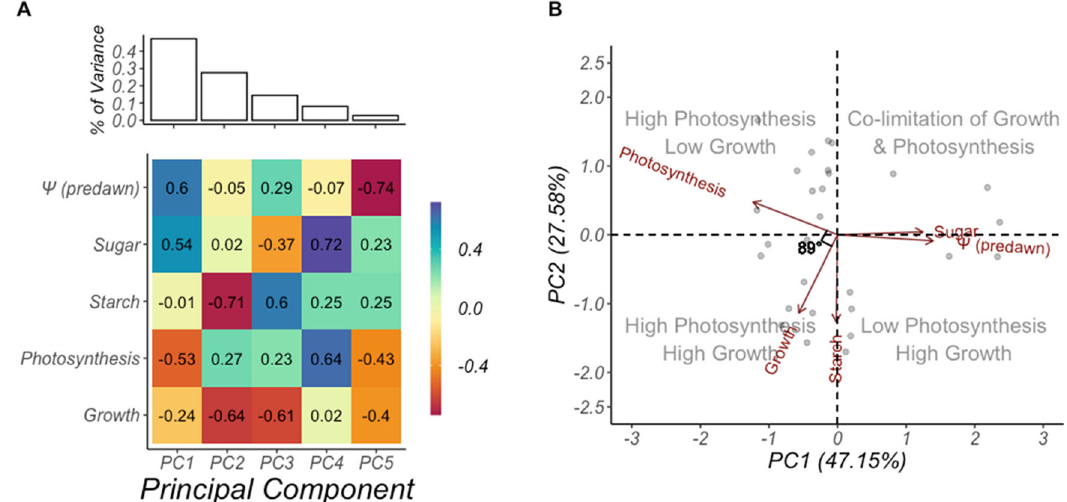
Fig. 5 | ψ pd couples photosynthesis to growth. During drought, carbon avail- ability is not the limiting process in fl uencing growth rate. Drought-induced reductions in cell turgor independently limits growth and photosynthesis, explaining both sink-source co-limitation and the lack of correlation between growth and photosynthetic rates. Results of the principal components analysis on carbon supply and demand variables reveals that water availability ( ψ pd ) limits growthandphotosynthesisandnotcarbonavailability.PC1explained47.15%ofthe total variance in the data, and together PC1 and PC2 explain 74.73% of the total variance in the data. Along PC1, ψ pd becomes more negative, drive sink-source co- limitation. Sugar concentrations increase as starch is depleted to support the metabolic and osmotic needs of both species. Growth and starch concentrations vary the most along PC2, re fl ecting the temporal patterns of plant phenology and starchaccumulation (SupplementaryFig.6). A Ascree plotshowing the amountof variance each principal component accounts for, and the eigenvectors associated